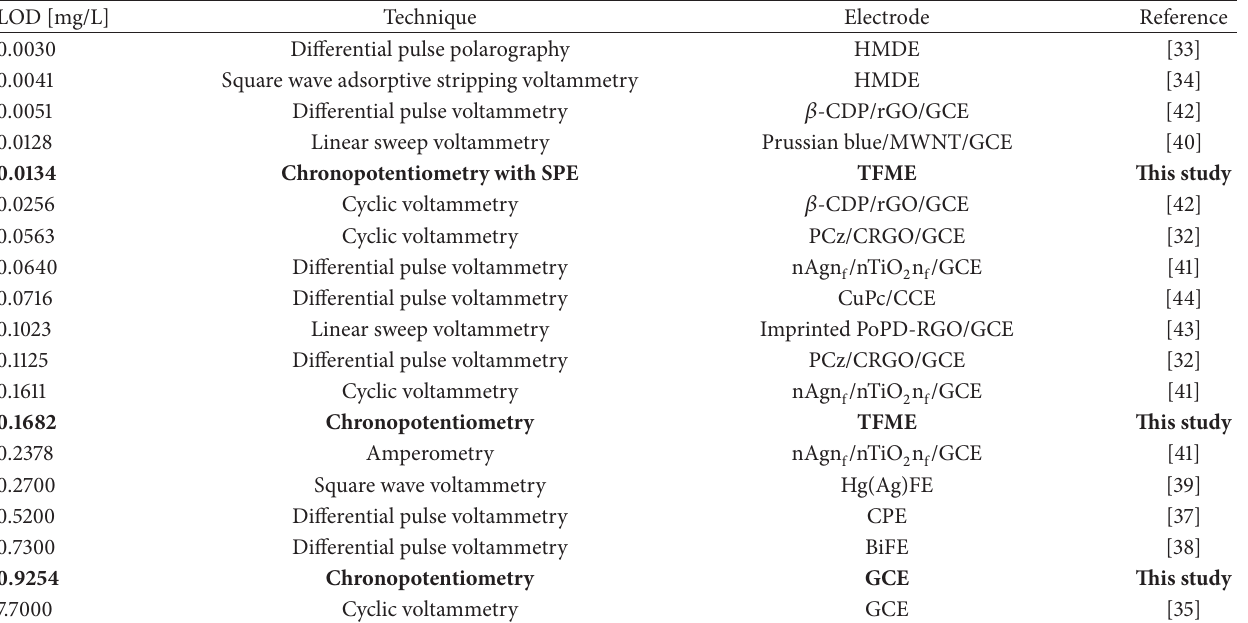
Table 2: Comparison of limit of detection (LOD) of the presented chronopotentiometric method with previously reported electrochemical methods for imidacloprid